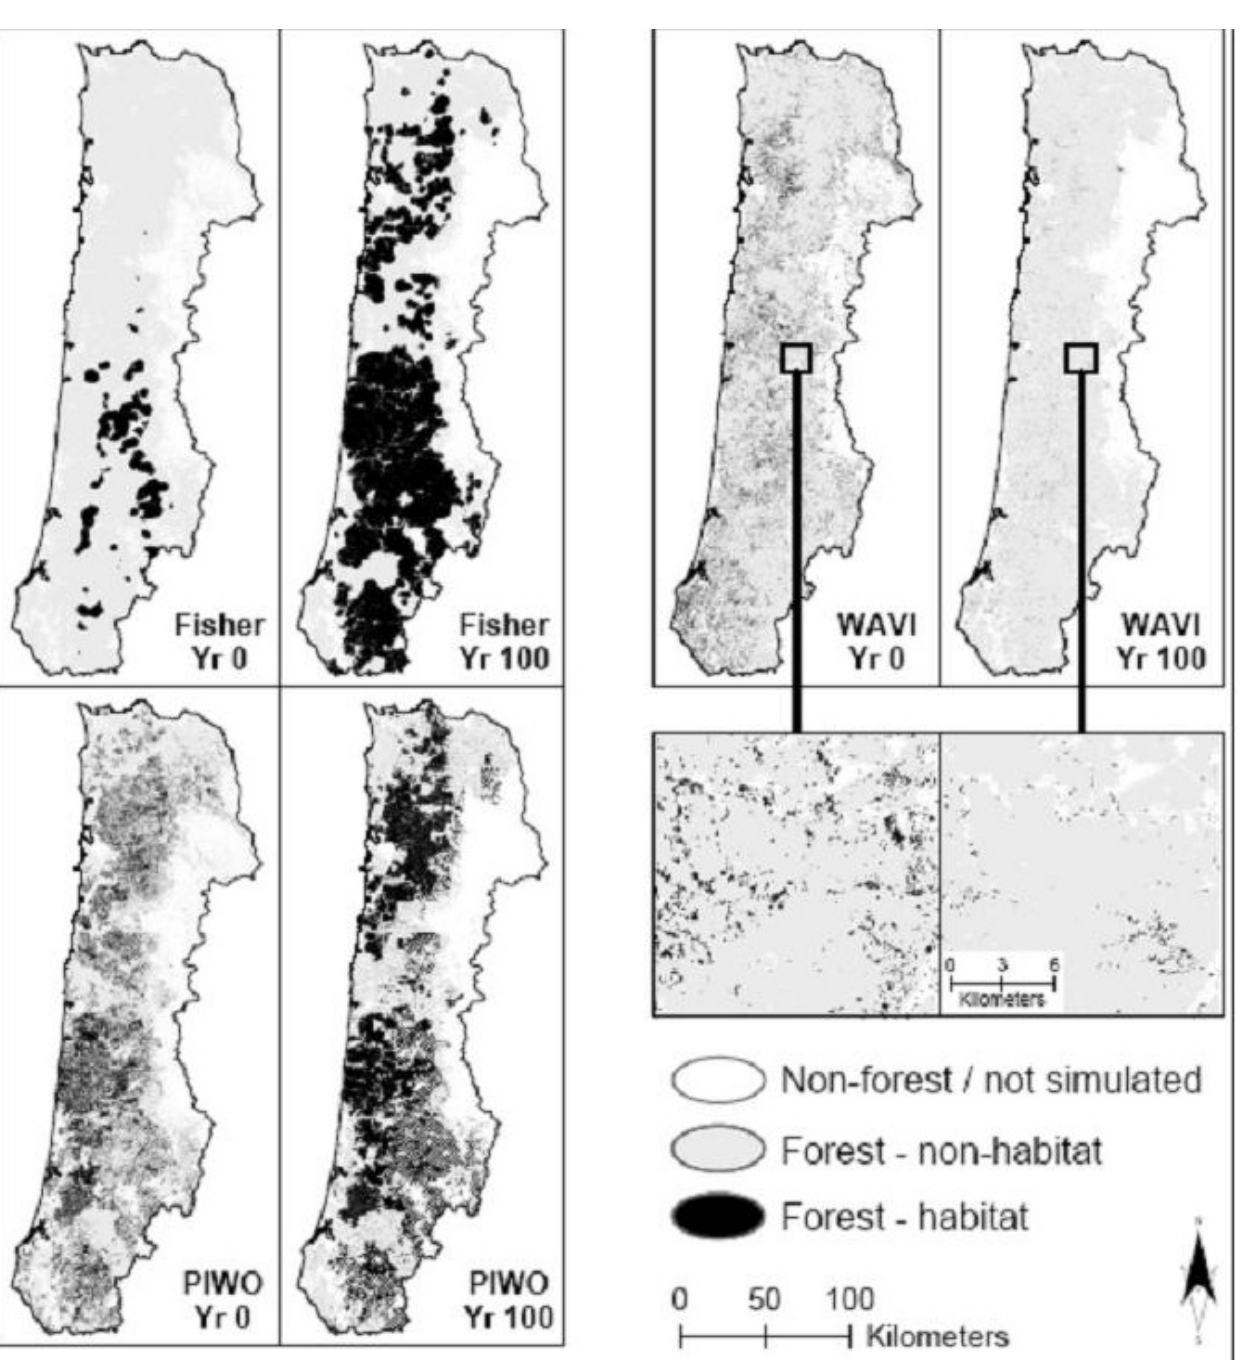
Fig. 2. Patterns of habitat change over a 100-yr simulation in the Oregon Coast Range under current land management policies on federal, state, and private forest lands for three focal species: Fisher = Pacific Fisher, WAVI = Warbling Vireo, and PIWO = Pileated